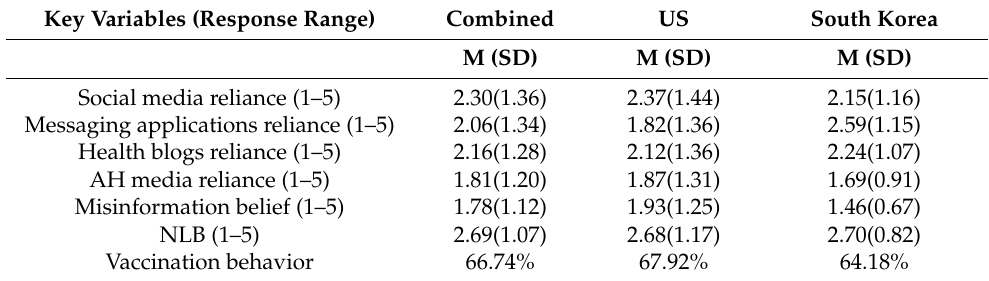
Table 2. Descriptive Statistics.